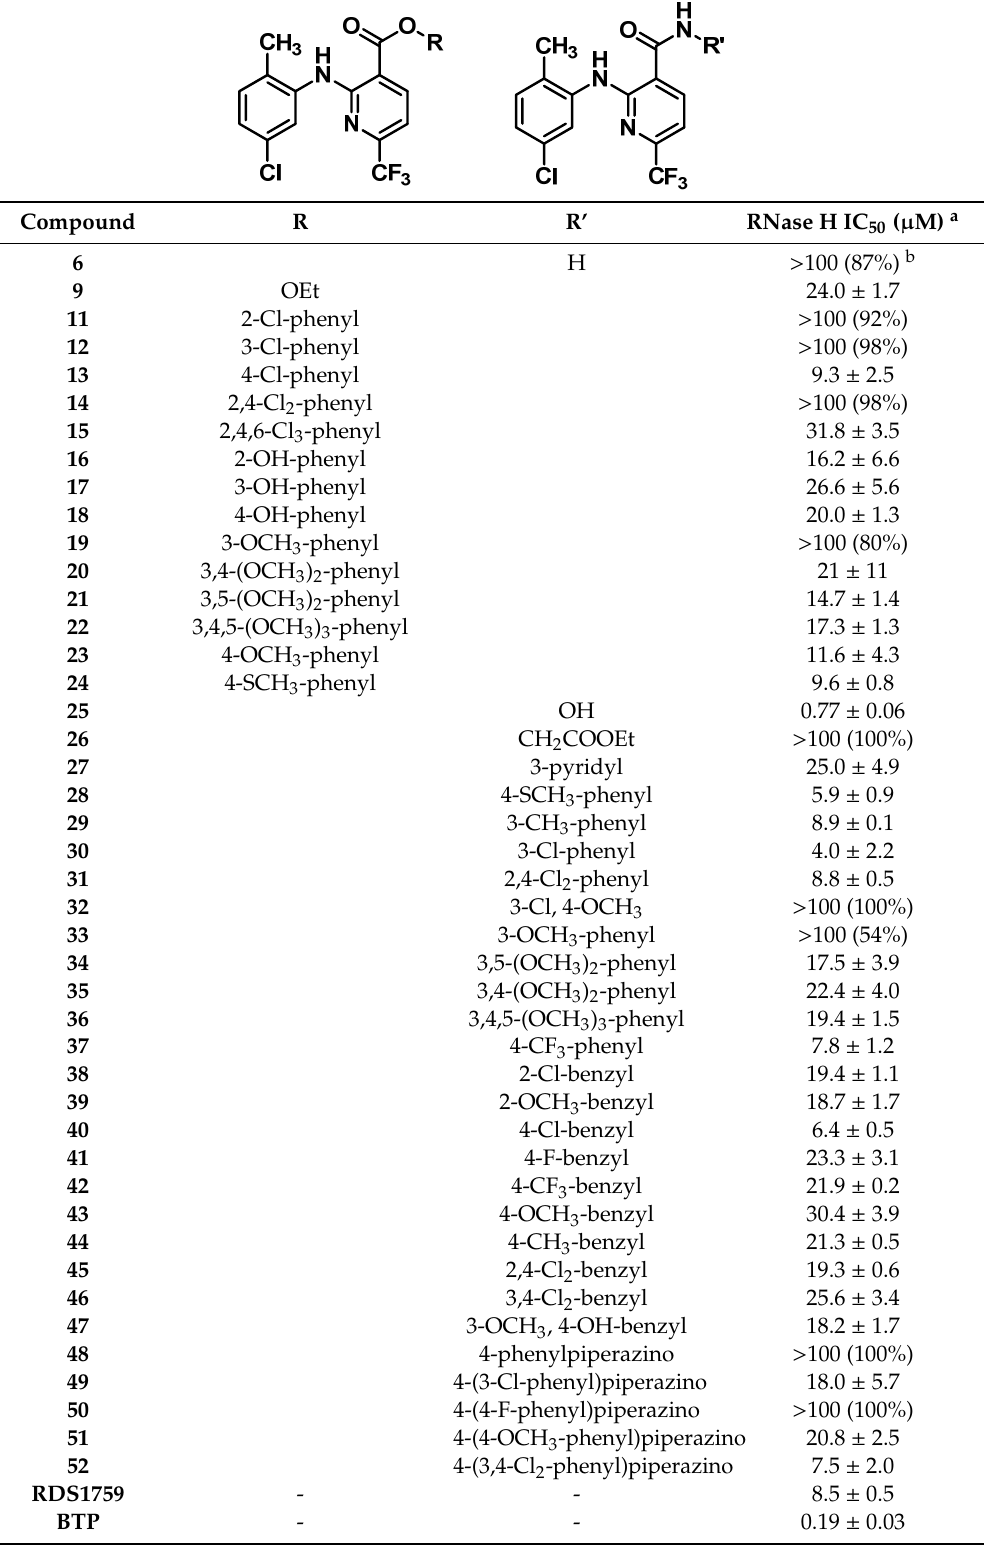
Table 1. Biological effects of derivatives on HIV ‐ 1 Reverse Transcriptase (RT) ‐ associated RNase H function.